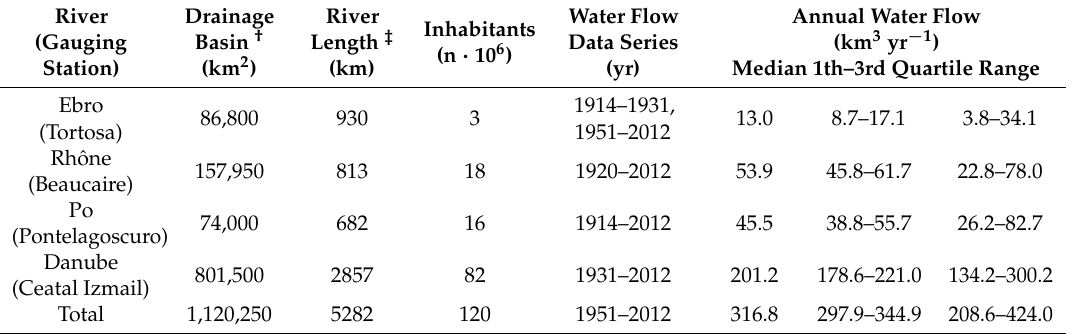
Table 1. General characteristics of drainage basins and river runoff (km 3 yr − 1 ) of the Ebro, Rh ô ne, Po and